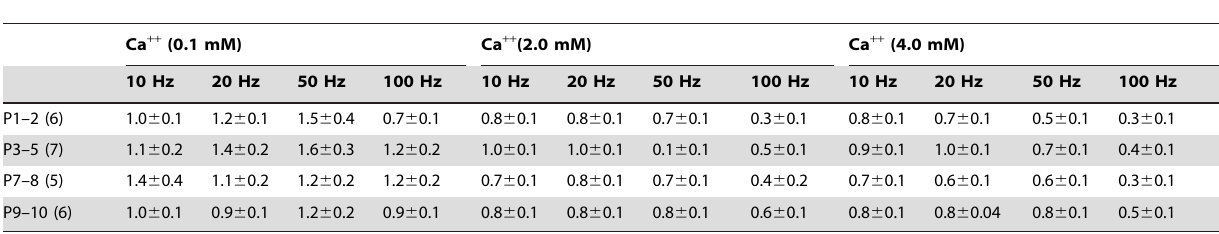
Paired pulse ratios for the glutamate component for different external Ca ++ concentrations, stimulation frequencies, and postnatal age. Non-parametric 1-way ANOVA (Kruskal-Wallis test) across age revealed no significant differences. The N of each age group is in parentheses. doi:10.1371/journal.pone.0075688.t002 PLOS ONE |